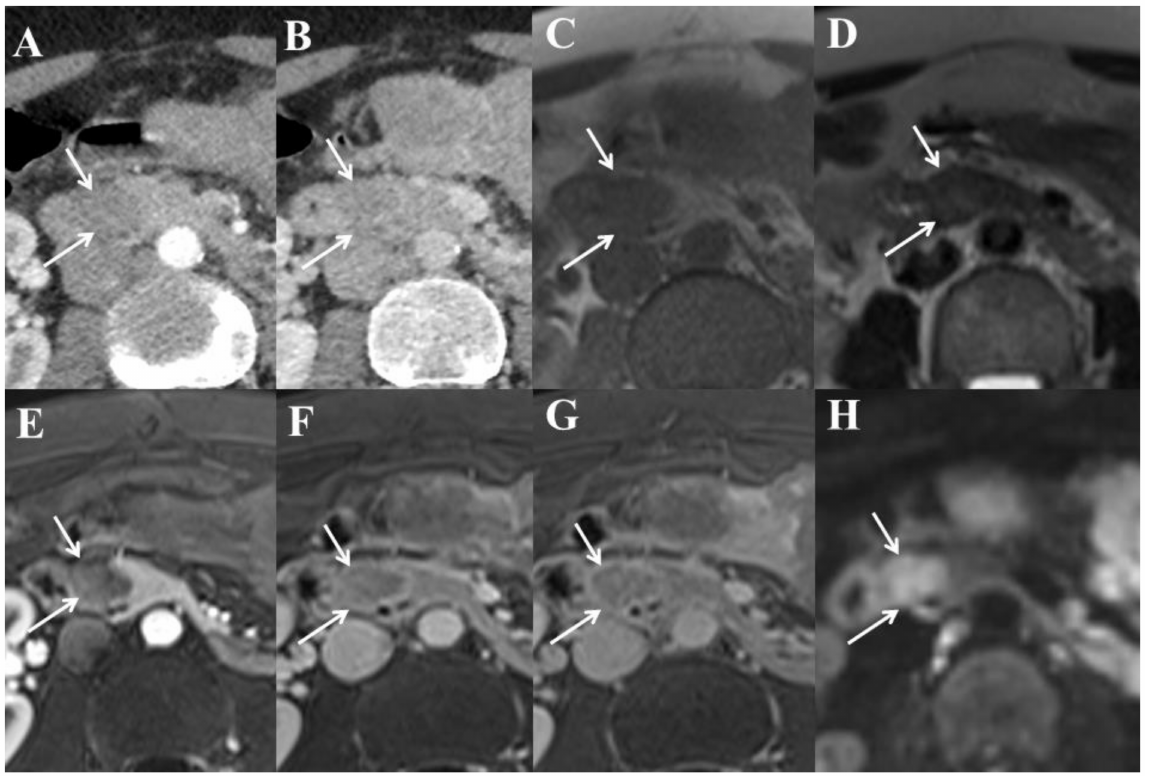
Figure 2. Forty-six-year-old woman with well-differentiated grade 3 neuroendocrine tumor (Ki-67 index = 28%) of the pancreatic head (PanNET G-3). ( A ) Computed tomography (CT) image in the axial plane obtained during the arterial phase following intravenous administration of iodinated contrast material reveals ill-defined, slightly hypoattenuating lesion (arrows) of the pancreatic head. The poor enhancement during arterial phase is in contrast with the classical hyperenhancement observed in well-differentiated PanNET G-1 and G-2. ( B ) On CT image obtained during the portal phase, the lesion (arrows) is hardly visible. ( C ) T1-weighted magnetic resonance (MR) image in the axial plane obtained before intravenous administration of a gadolinium-based contrast agent shows hypointense pancreatic lesion (arrows). ( D ) T2-weighted MR image shows ill-defined and slightly hyperintense pancreatic lesion (arrows). ( E ) T1-weighted MR image in the axial plane obtained during the arterial phase following intravenous administration of a gadolinium-based contrast agent clearly shows well-defined and markedly hypointense pancreatic lesion (arrows). The poor enhancement during arterial phase is in contrast with the classical hyperenhancement observed in well-differentiated PanNET G-1 and G-2. ( F ) On T1-weighted MR image obtained during the portal venous phase of enhancement, the lesion (arrows) remains hypointense relative to the adjacent pancreatic parenchyma. ( G ) On T1-weighted MR image obtained during the late phase of enhancement, the lesion (arrows) remains hypointense relative to the adjacent pancreatic parenchyma. ( H ) Diffusion-weighted MR image (b = 1000 s/mm 2 ) in the axial plane shows hyperintense pancreatic lesion (arrows). The tumor had a low apparent diffusion coefficient of 0.952 × 10 − 3 mm 2